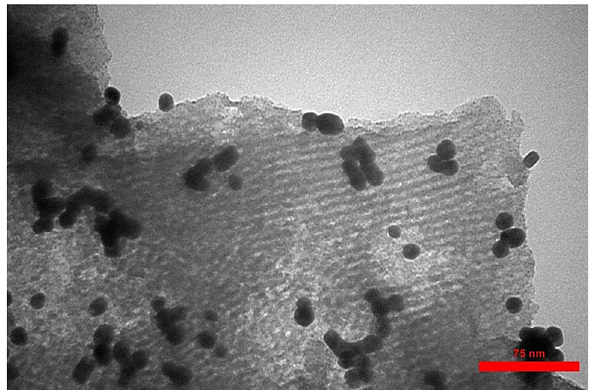
Figure 4. TEM images of the KIT-5-biguanidine-Au(0) nanocomposite.